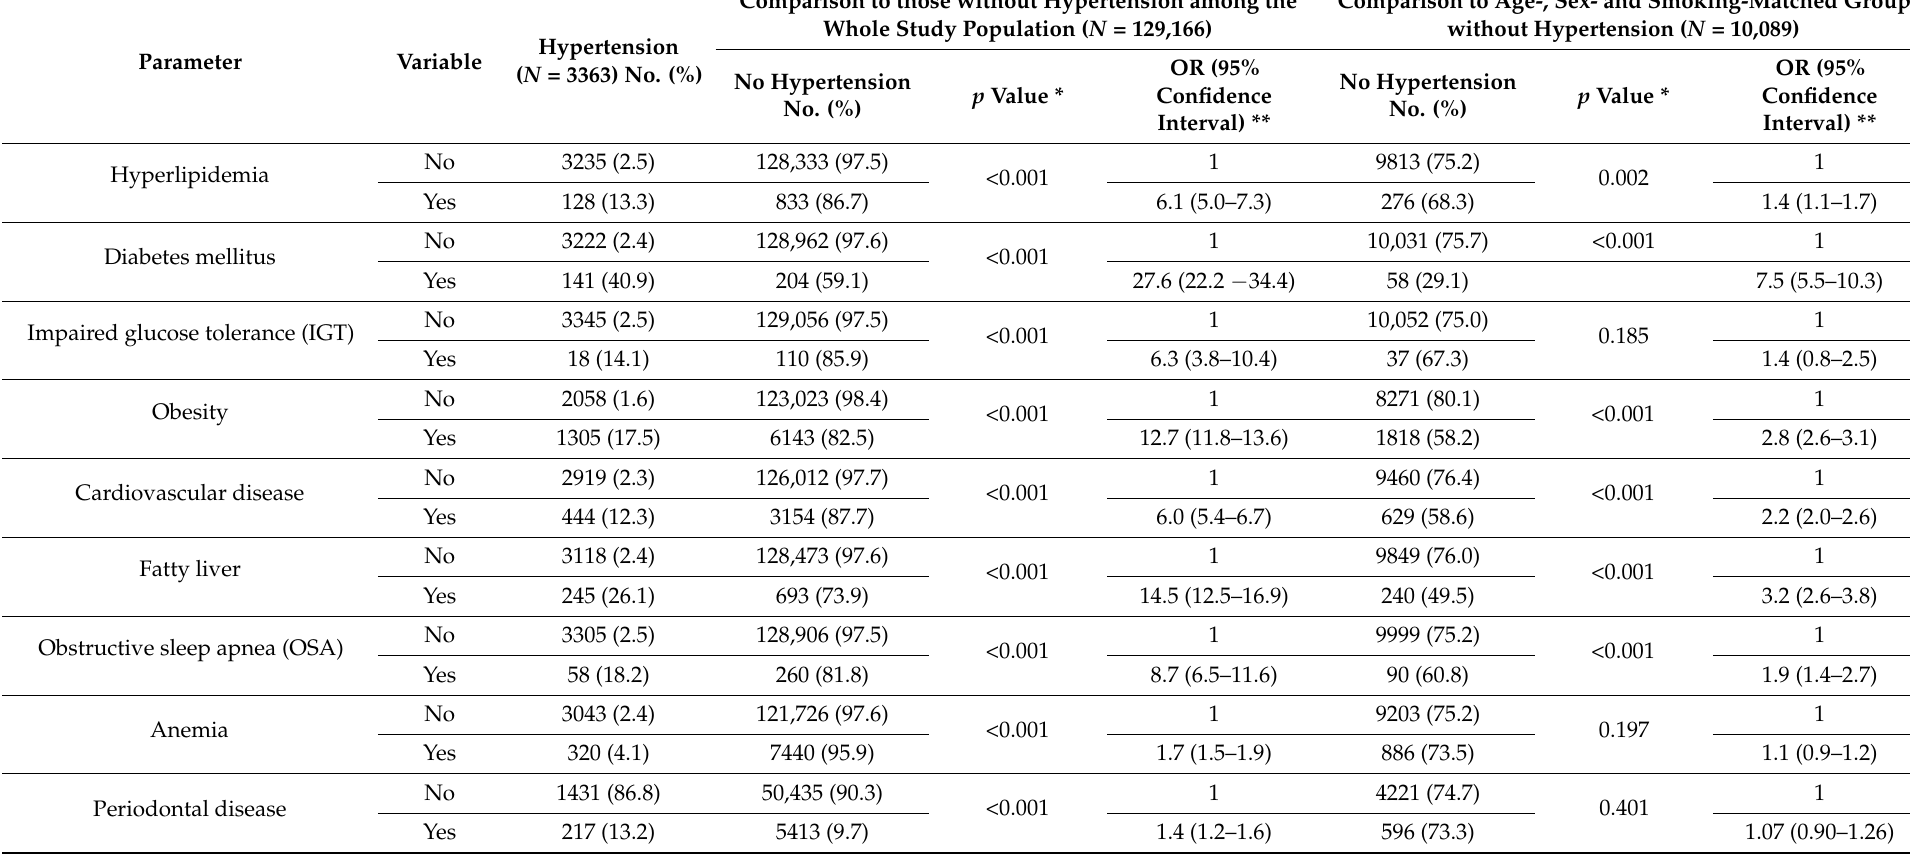
Table 3. The associations between general health status and periodontal disease with hypertension diagnosis among the study population and among the age-, sex- and smoking-matched